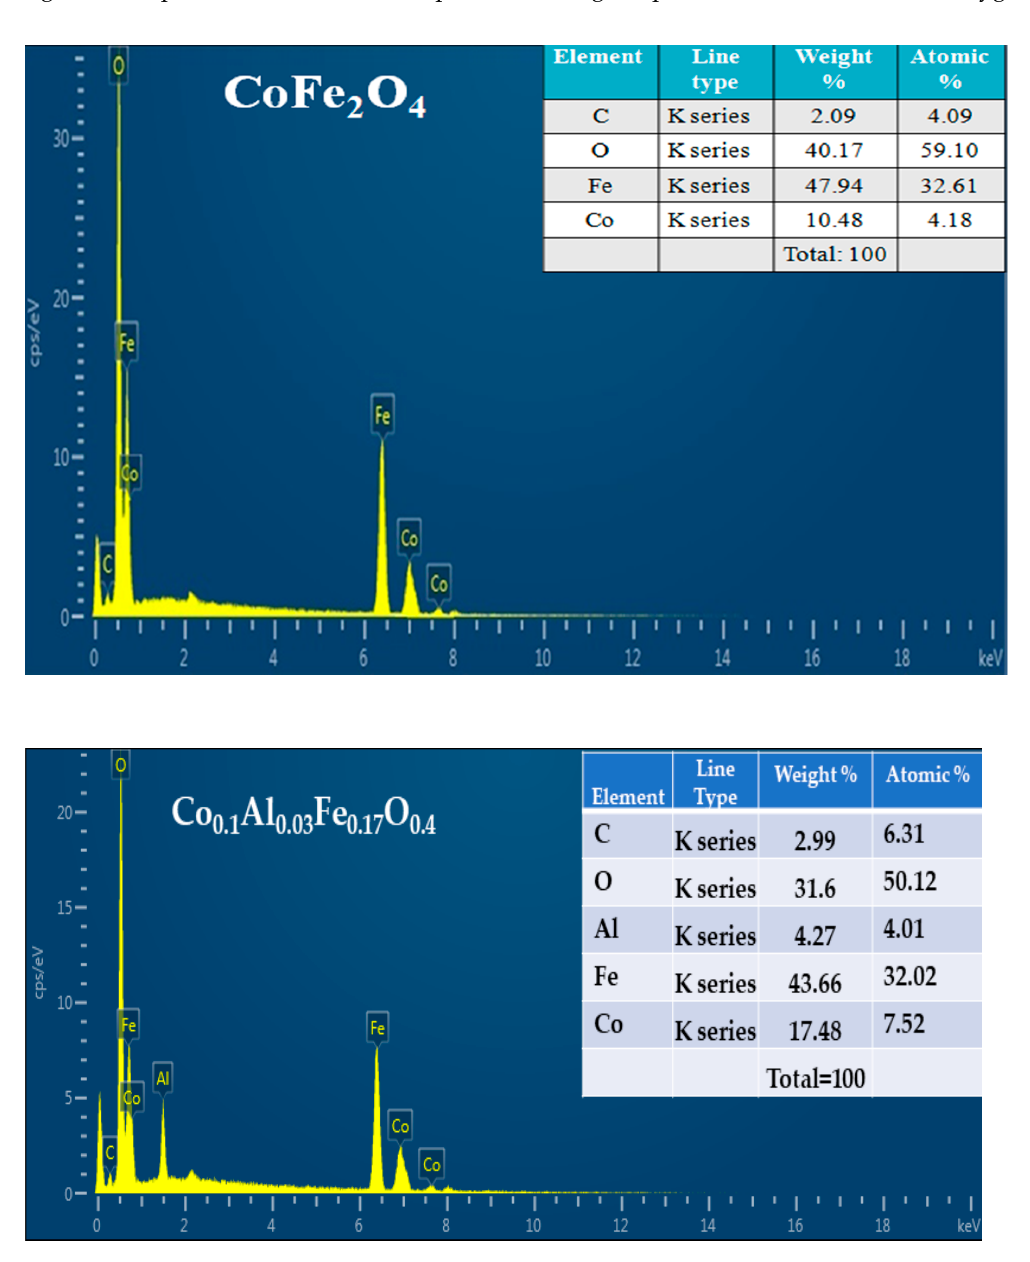
2 O 4 and Co 0.1 Al 0.03 Fe 0.17 O 0.4